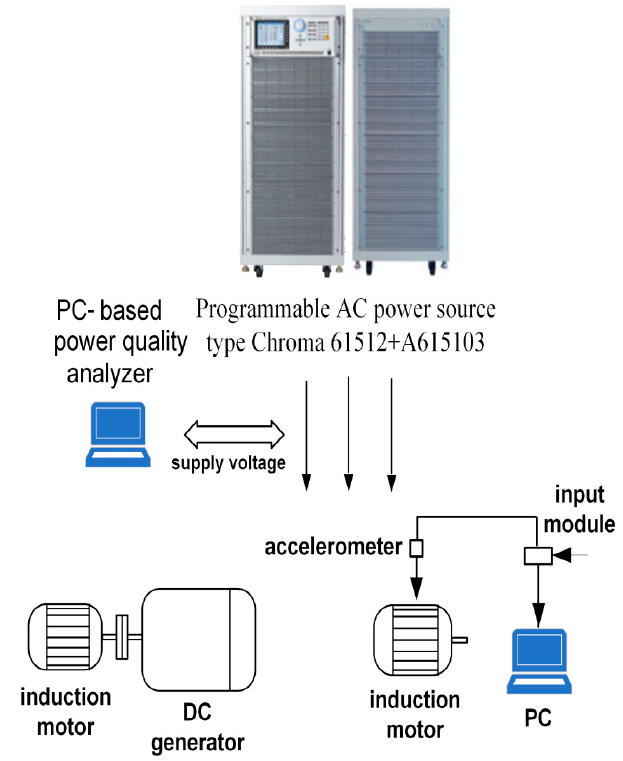
Figure 7. Simplified diagram of the measurement stand.